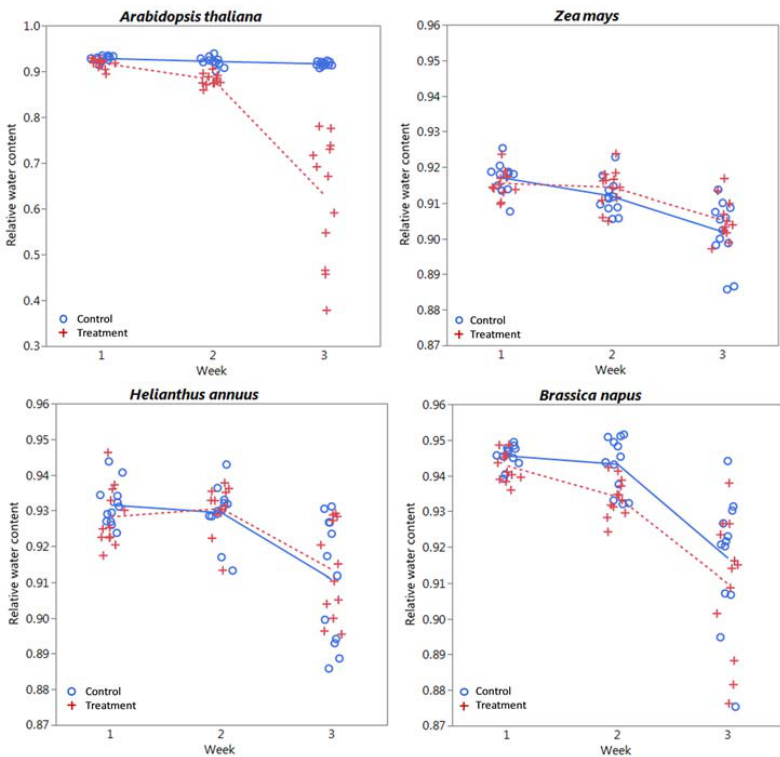
Figure 6 . Relative water content (RWC) by week and treatment level for each species considered. Lines (solid = control, dashed = treatment) indicate mean values at each week.